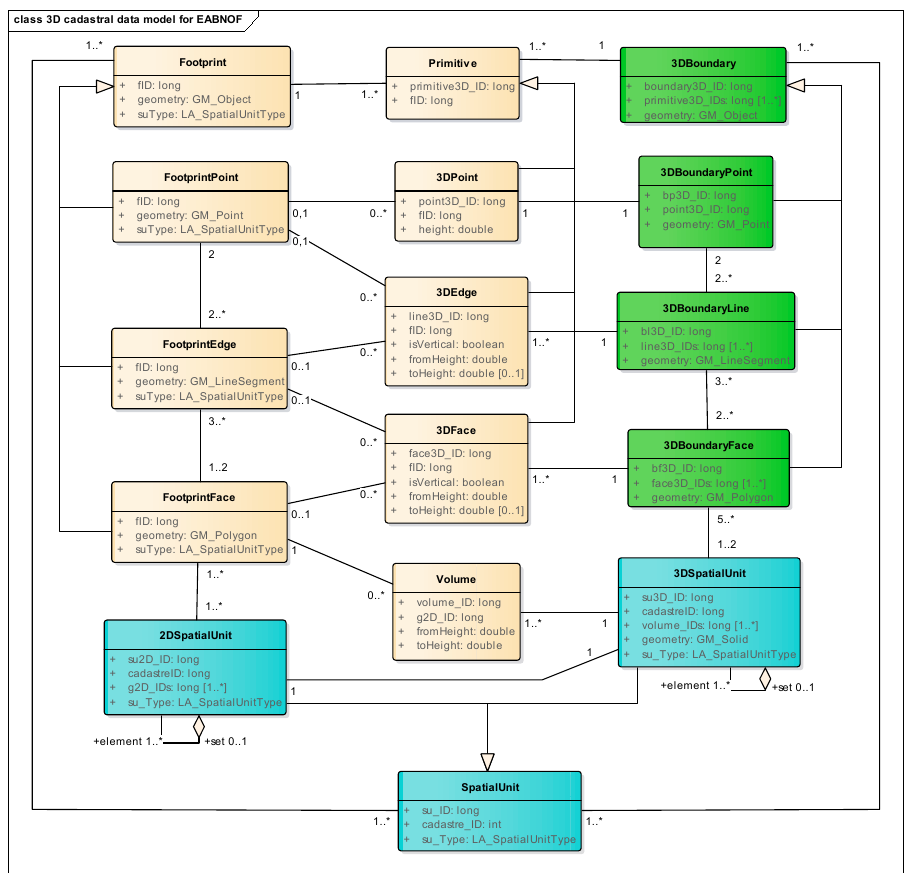
Figure 4. 3D cadastral data model for EABNOF.